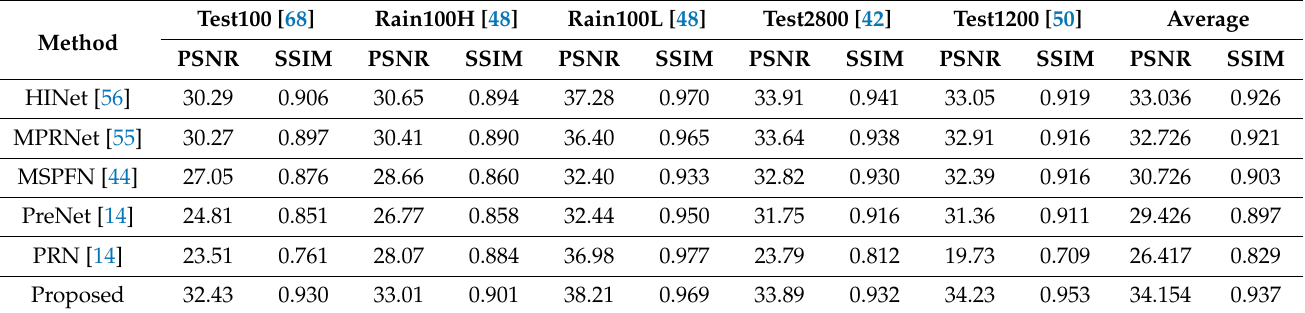
Table 3. Average PSNR and SSIM comparison on the synthetic datasets Test100, Rain100H, Rain100L, Test2800, and Test1200.